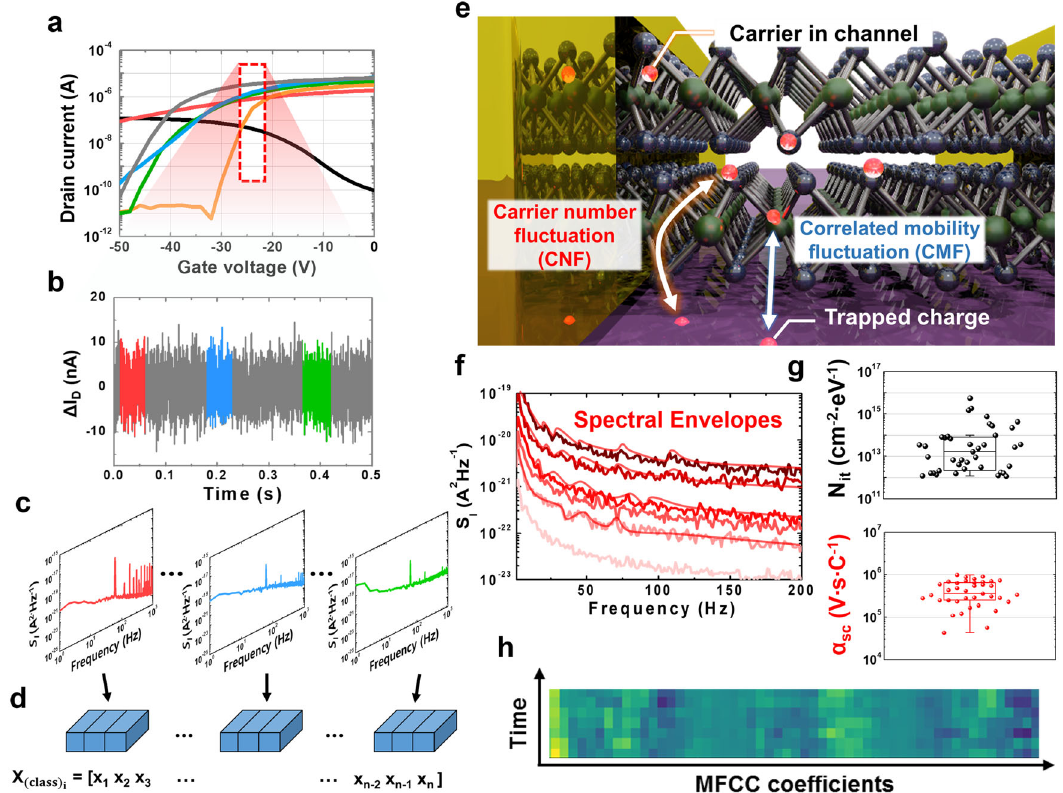
Fig. 3 Detailed fl owchart of Δ I D featurization. a Transfer characteristics ( I D − V G ) of 2D layered FETs measured under various conditions; b Δ I D (t) data measured at a particular V D and V G and then divided into speci fi c frames with sampling period; c current power spectral densities ( S I ) in the frequency domain of each frame converted through FFT; d current MFCC comprising 2D array, X ( class ) i , obtained by concatenating current MFCC vector, x , processed through Mel fi lter and DCT; e sectional illustration of carrier behavior in a 2D layered FET; f S I ( f ) at a particular V D for several V G and spectral envelopes (the darker color, the larger V G ); g N it and α SC distributions, which were calculated by carrier number fl uctuation-correlated mobility fl uctuation (CNF-CMF) model of each class (the box plots are de fi ned by 25th and 75th percentile); h engineered current MFCC 2D array, which contains carrier behaviors (the darker color, the smaller